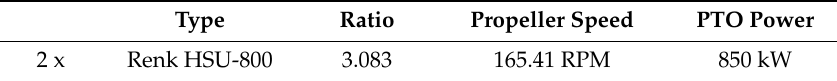
Table 4. Gearbox and power take out (PTO)